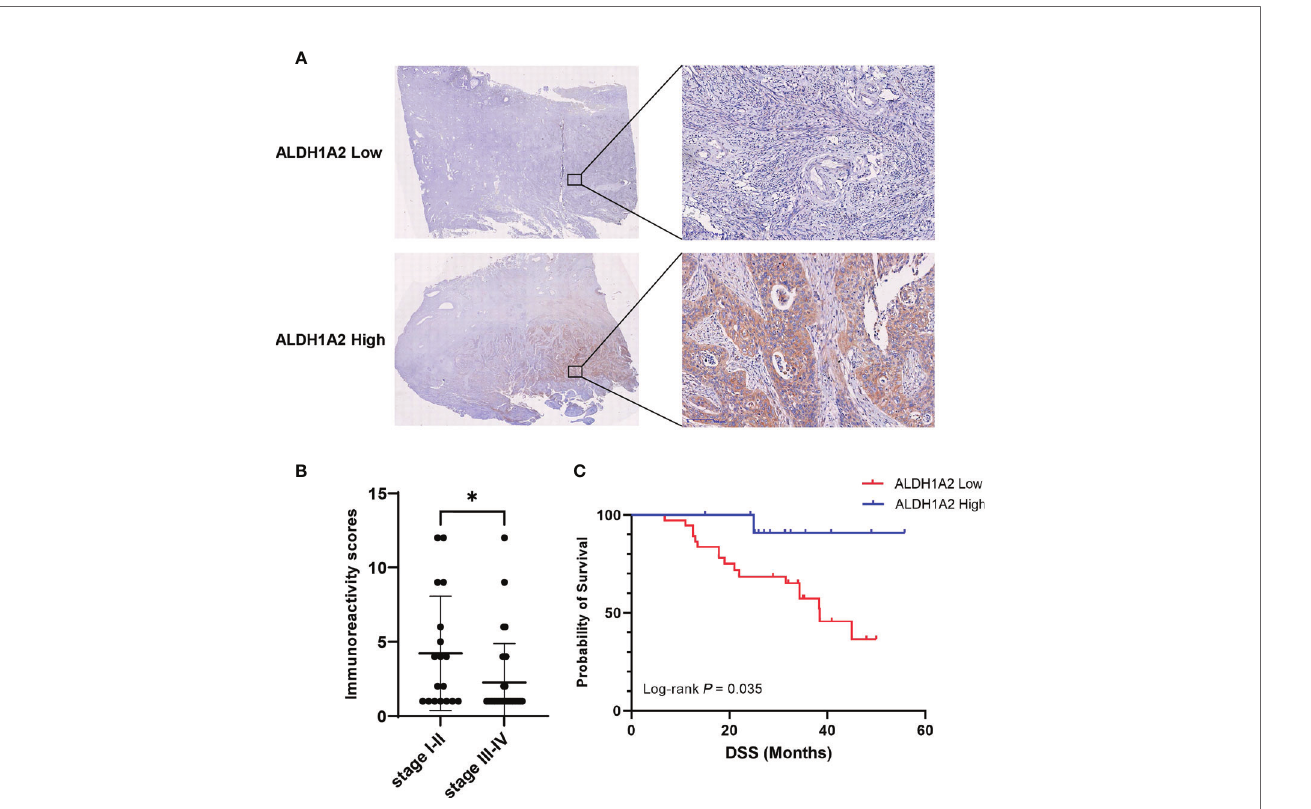
FIGURE 5 | Correlation between ALDH1A2 protein levels and clinical prognosis of patients with cervical cancer. (A) Representative pictures of IHC stained primary tumor sections with different expression of ALDH1A2 protein levels (brown signal). Counterstaining with hematoxylin. Scale bars:100 m m. (B) Immunoreactivity scores were compared between the low clinical stage (I/II) (n=18) and the high clinical stage (III/IV) (n=32). Bars depict mean values ± SEM of IRS, * P < 0.05. (C) Disease-speci fi c survival of patients with cervical cancer separated by high versus low ALDH1A2 expression. P -value was derived by log-rank